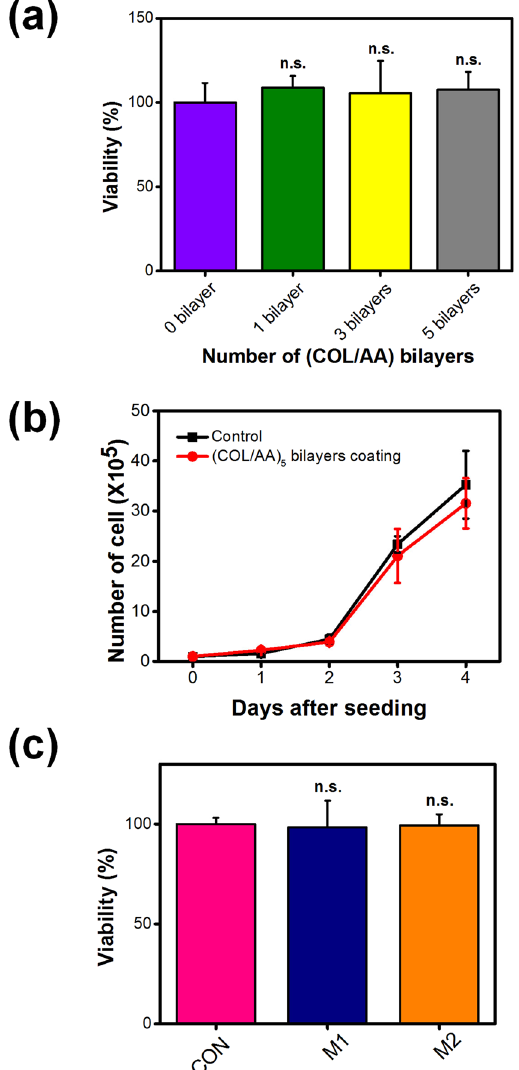
Figure 2. C2C12 single cell viability as a function of the number of (COL/AA) bilayers comprising the multi- layer films that are fabricated on the cell surfaces ( a ), proliferation of C2C12 cells coated in films consisting of five (COL/AA) bilayers, as well as of uncoated cells, for 4 days after seeding ( b ), and viability of CON cell sheets and sheets coated in (COL/AA) 5 multi-layer films fabricated through the two different application methods ( c ). Statistical analysis performed by Tukey’s method and n.s., not significant; versus